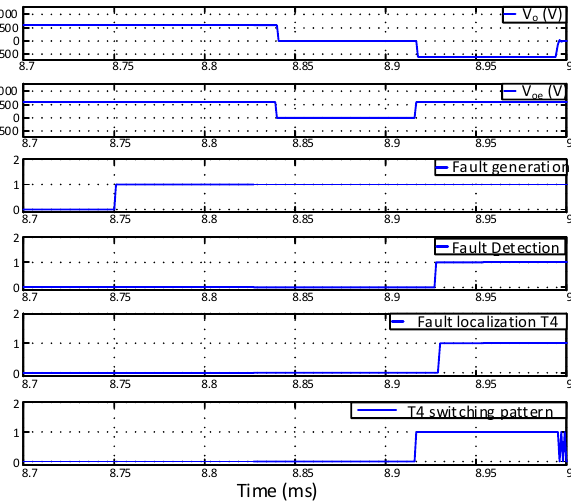
Fig. 7 Simulation results when Tc1+ is faulty (OCF).